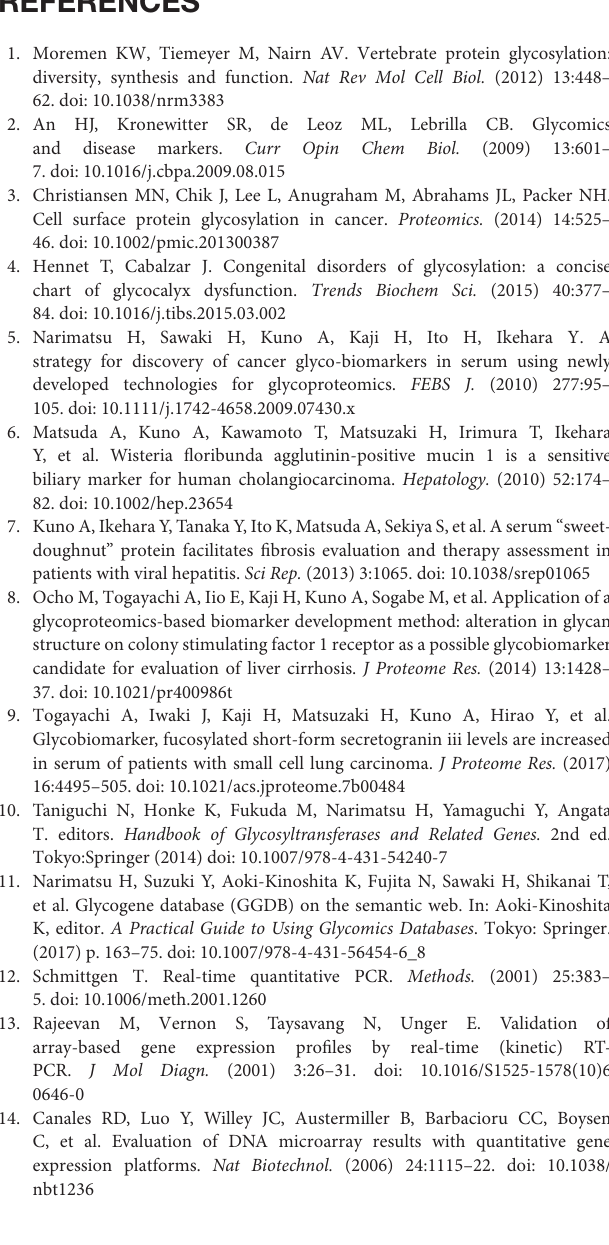
Figure S1 | RNA-Seq data were compared using the GeneChip RMA from the GEO database obtained from HuH7 cells (GSM618131, 26). The x-axis is from the GeneChip RMA and the y-axis presents log2 transformed RNA-Seq data. The linear distribution indicates a similar expression of the gene between two different transcriptome analyses. Figure S2 | Cluster analysis of glycogenes expression from 31 patients in the TCGA-LIHC project (listed in Table S4 ). Cluster analysis was performed as